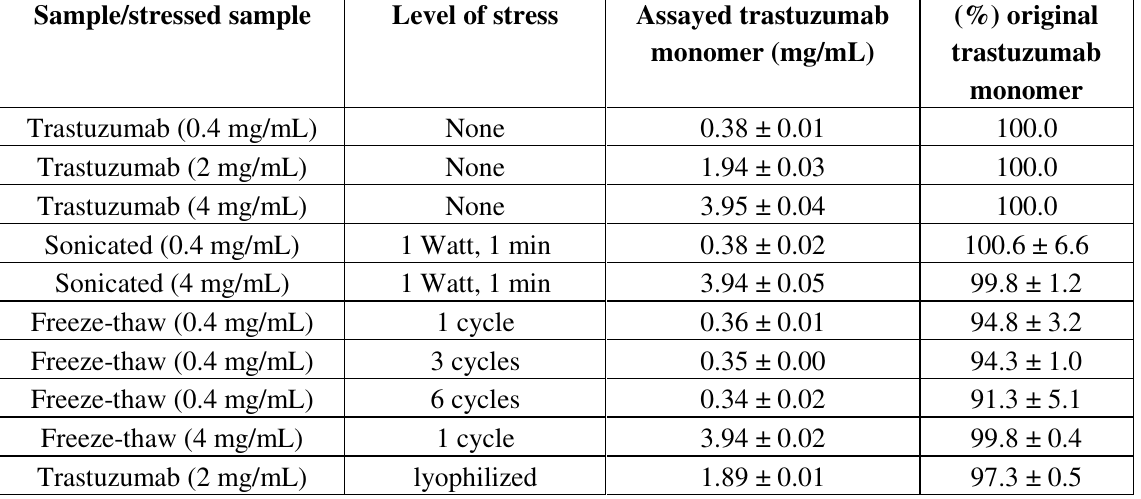
Table 1. Concentration of trastuzumab monomer as determined by size exclusion chromatography (SEC) after subjected to various mechanical stress. Data shown as mean of n = 3 ± SD.